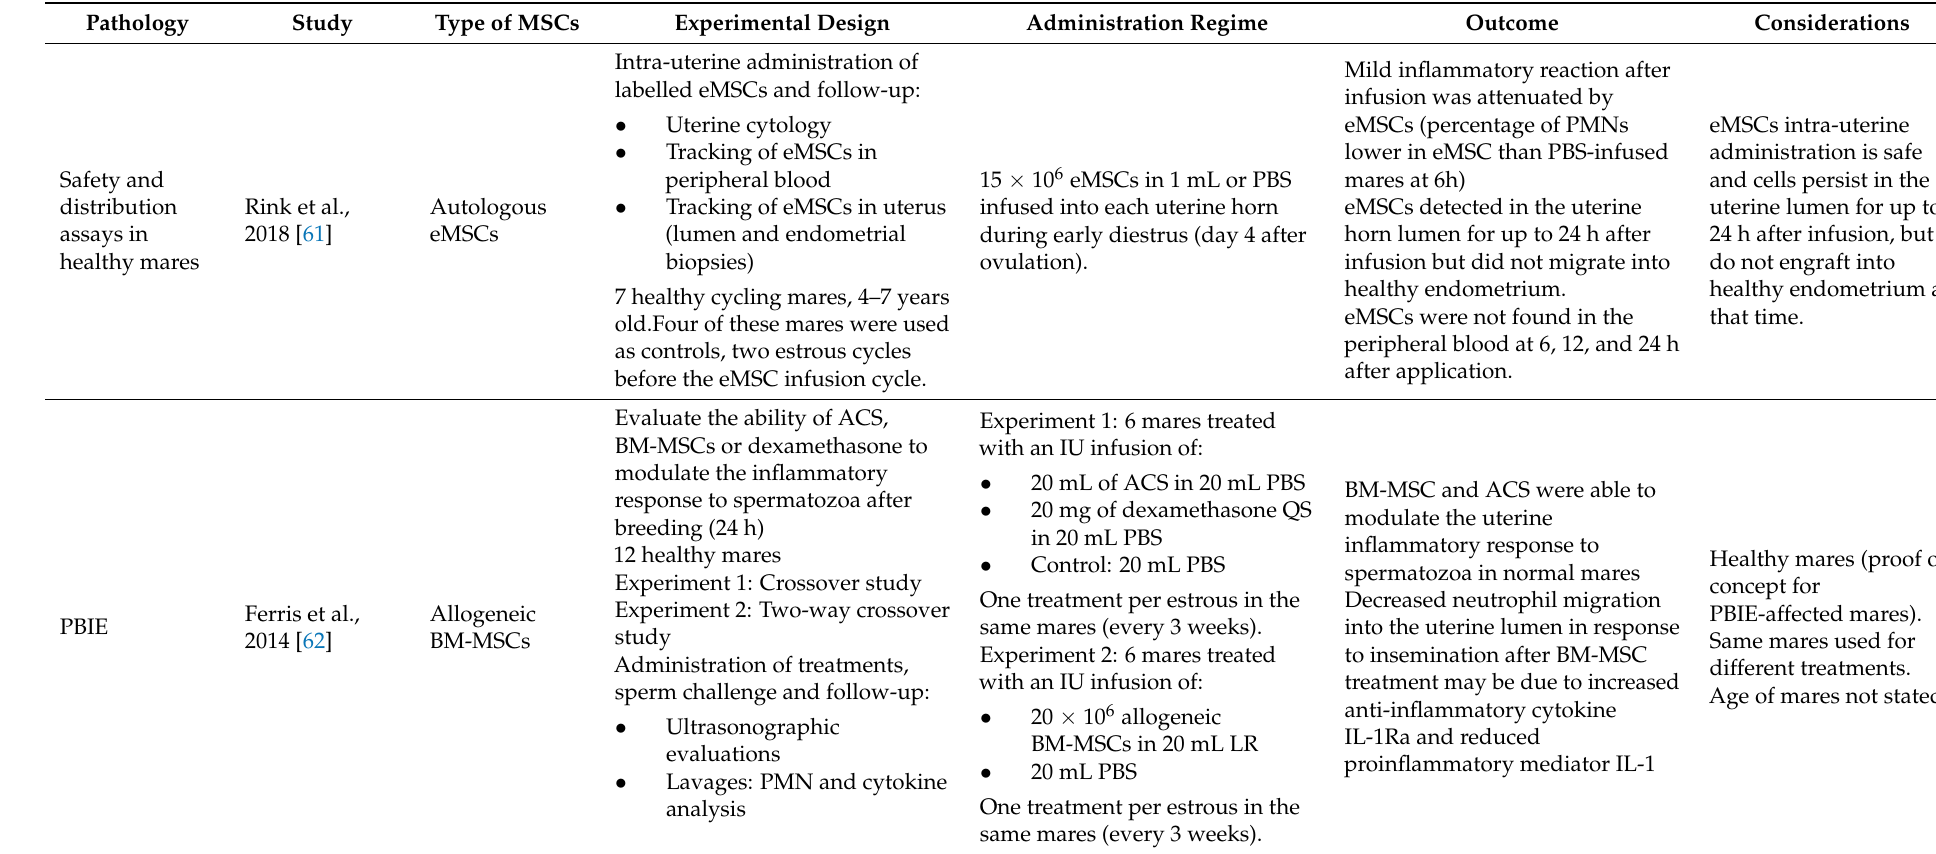
Table 2. In vivo studies using mesenchymal stem cells in equine reproduction. Endometrial mesenchymal stromal cells (eMSCs), phosphate-buffered saline (PBS), polymorphonuclear neutrophils (PMNs), bone marrow mesenchymal stem cells (BM-MSCs), anti-Müllerian hormone (AMH), autologous conditioned serum (ACS), lactate ringer (LR), intrauterine (IU), post-breeding induced endometritis (PBIE), adipose tissue MSCs (AT-MSCs), artificial insemination (AI), fetal bovine serum (FBS), dimethyl sulfoxide (DMSO), interleukin 6 (IL-6),